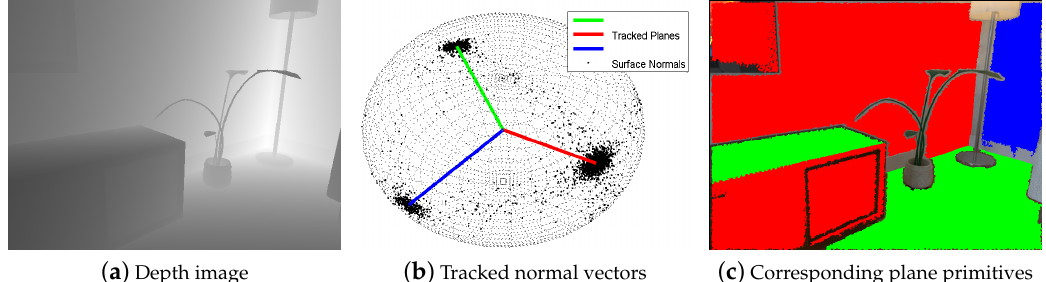
Figure 4. Result of tracking planes: ( a ) Depth image of Frame 741 in the ‘LivingRoom2’ sequence of the ICL-NUIM dataset. ( b ) Tracked normal vectors from the Gaussian sphere; black dots represent the normals of initial nodes. ( c ) Plane primitives in current frame. Tacked normal vectors and their corresponding planes in image domain are represented with the same